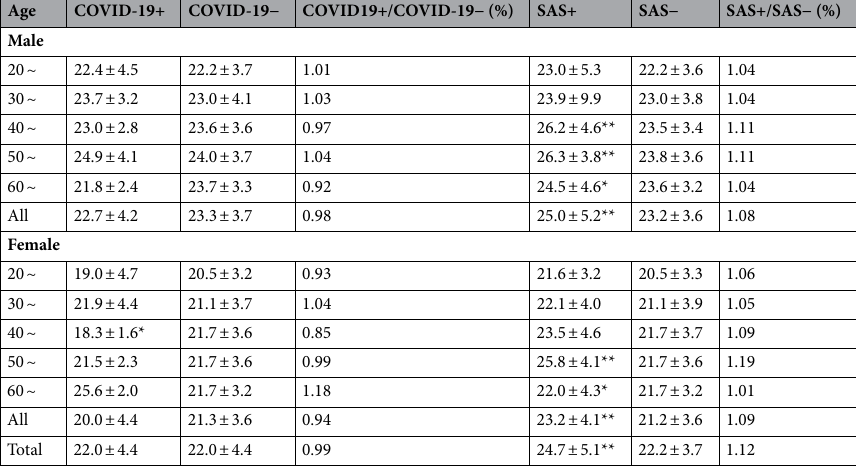
Table 2. BMI (mean ± SD) values and COVID/Sleep Apnea status in each age group. The values are displayed mean ± SD. **p < 0.01, * p < 0.05, Mann–Whitney U test.